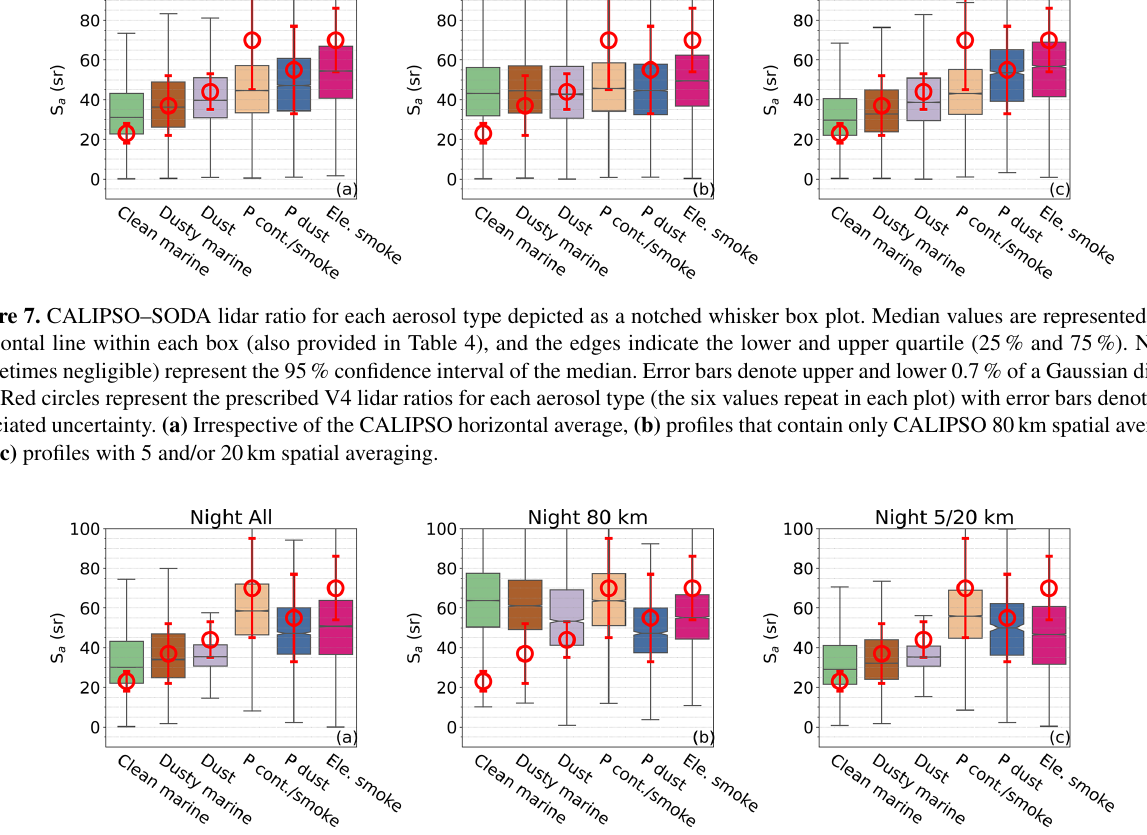
Figure 8. Lidar ratio as in Fig. 7 but for nighttime. (a) Irrespective of the CALIPSO horizontal average, (b) profiles that contain only CALIPSO 80km spatial averaging, and (c) profiles with 5 and/or 20km spatial averaging. Legends and description of the whisker box plot are described in Fig. 7.